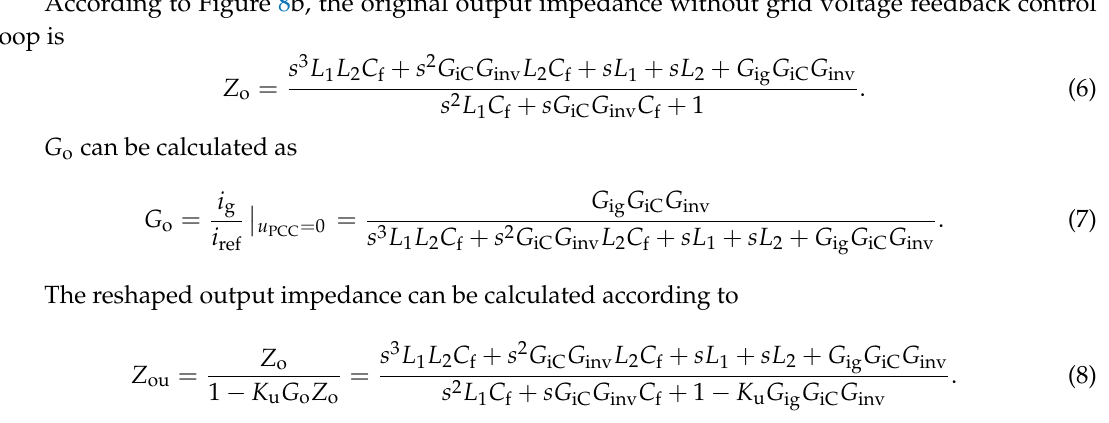
feedback control loop; ( b ) control